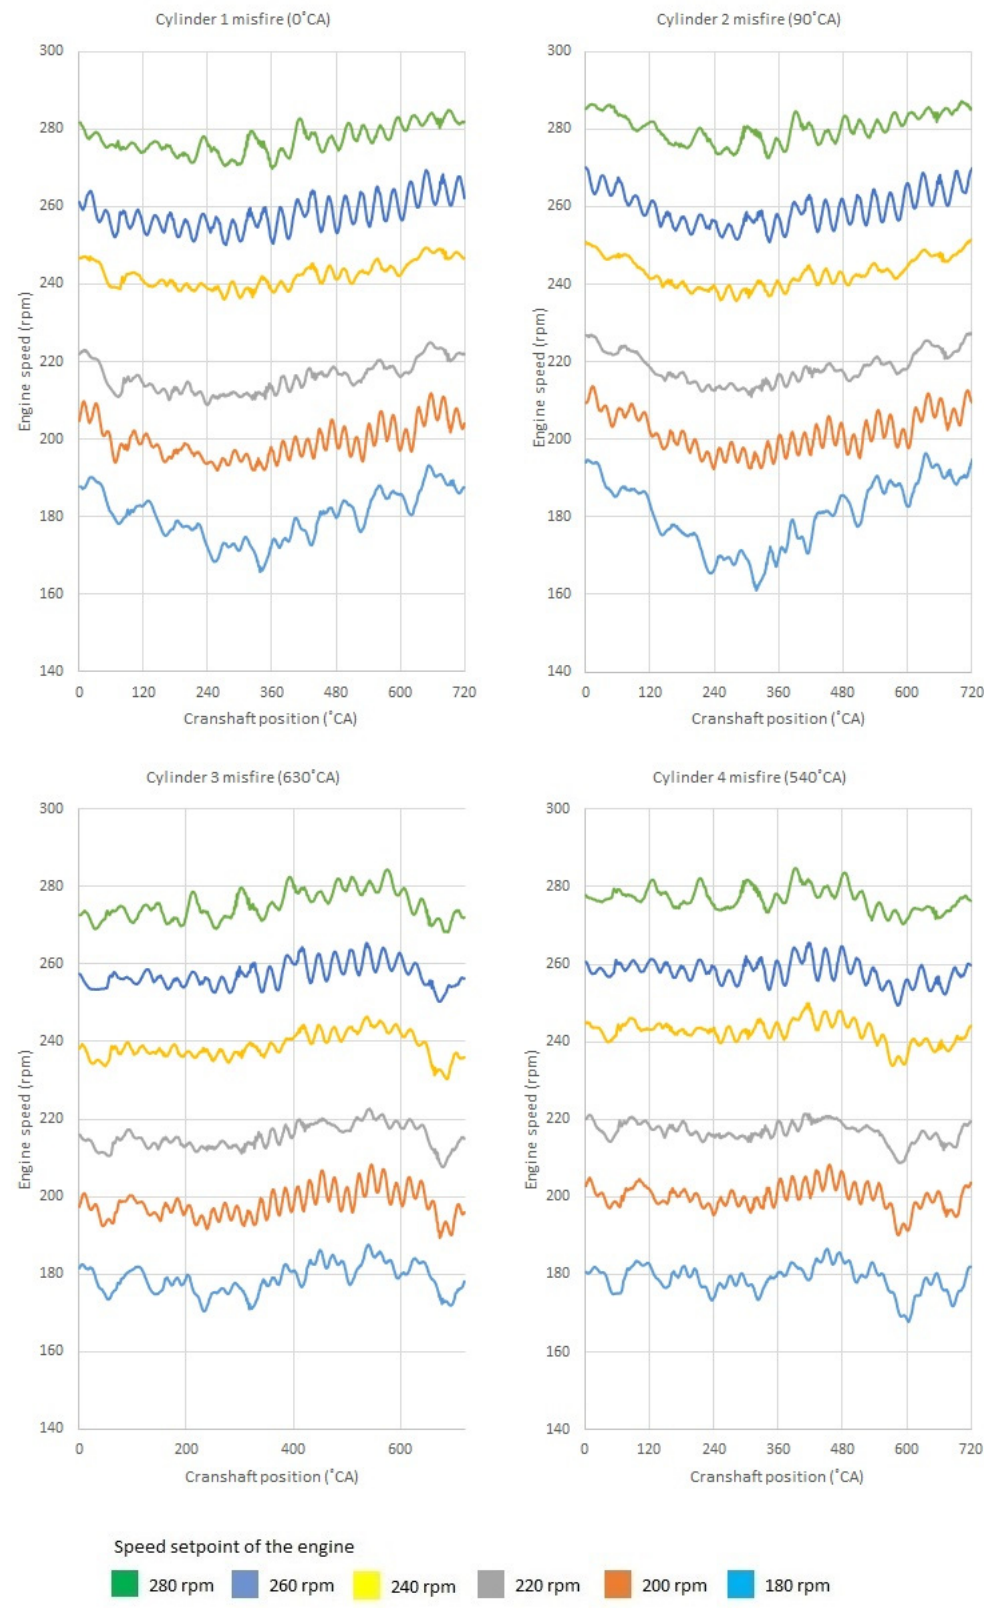
Figure 13. Instantaneous speed ranges at the time of combustion loss in cylinders 1–4 of a Buckau-Wolf R8DV-136 engine with pre-set speeds of 180–280 rpm.